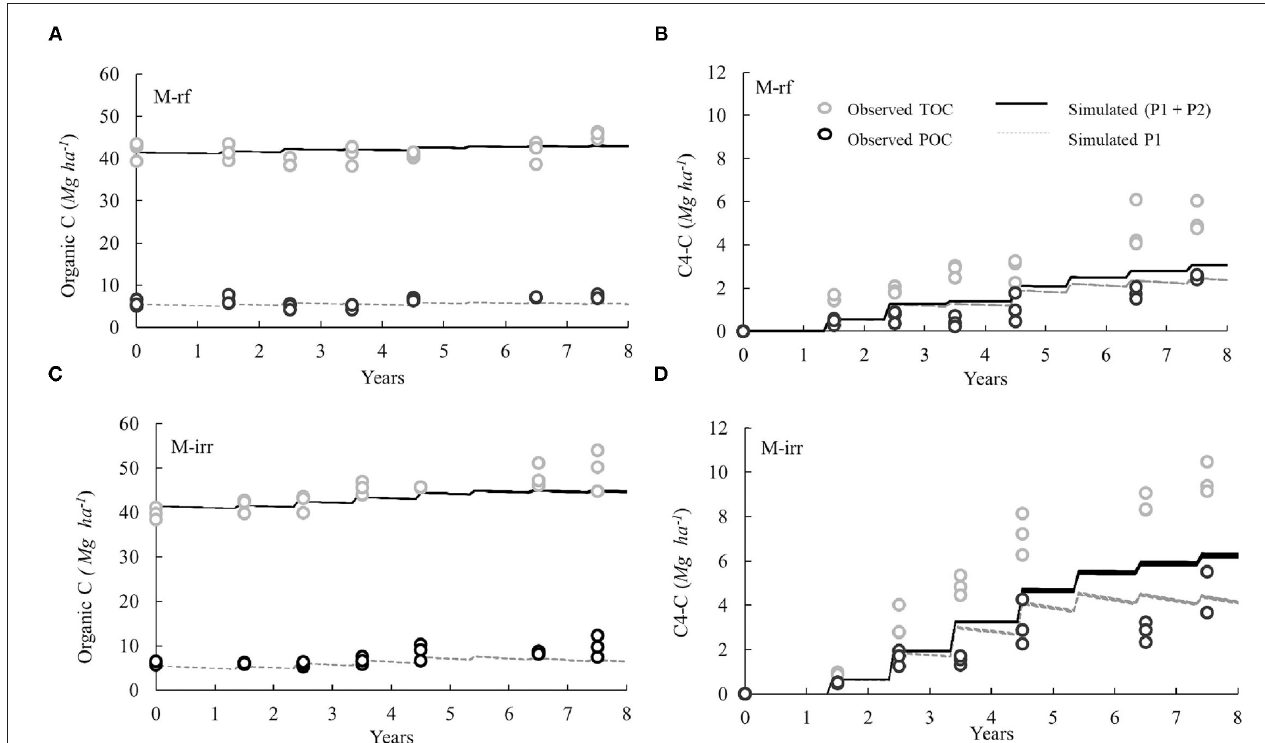
FIGURE 6 | Simulations of organic C and C4-C stocks dynamics in P1 (gray dashed lines) and (P1 + P2) (dark lines) with the sequential model. The 50 best fits are represented. Total organic C (TOC, gray dots) and particulate organic C (POC, dark dots) observed data are also displayed ( n = 3). Organic C (A) , C4-C stocks (B) , in M-rf (maize, rainfed) on top panels and organic C (C) , and C4-C stocks (D) in M-irr (maize, irrigated) on bottom panels.